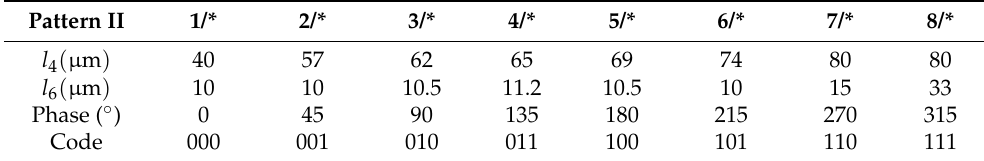
Table 2. Parameters of the eight structures of Pattern II.